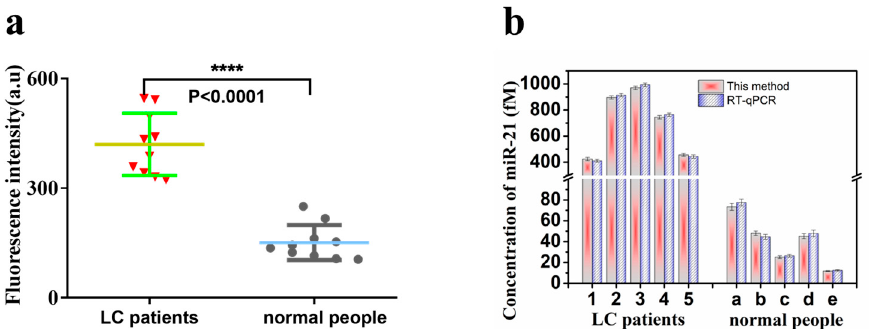
Figure 7. ( a ) A fluorescence biosensor for the detection of exosomal miR-21 from lung cancer patients and normal people (**** p < 0.0001) (error bars: SD, n = 10). ( b ) The expression of exosomal miR-21 was detected by the fluorescence biosensor and RT-qPCR, respectively (error bars: SD, n = 3).